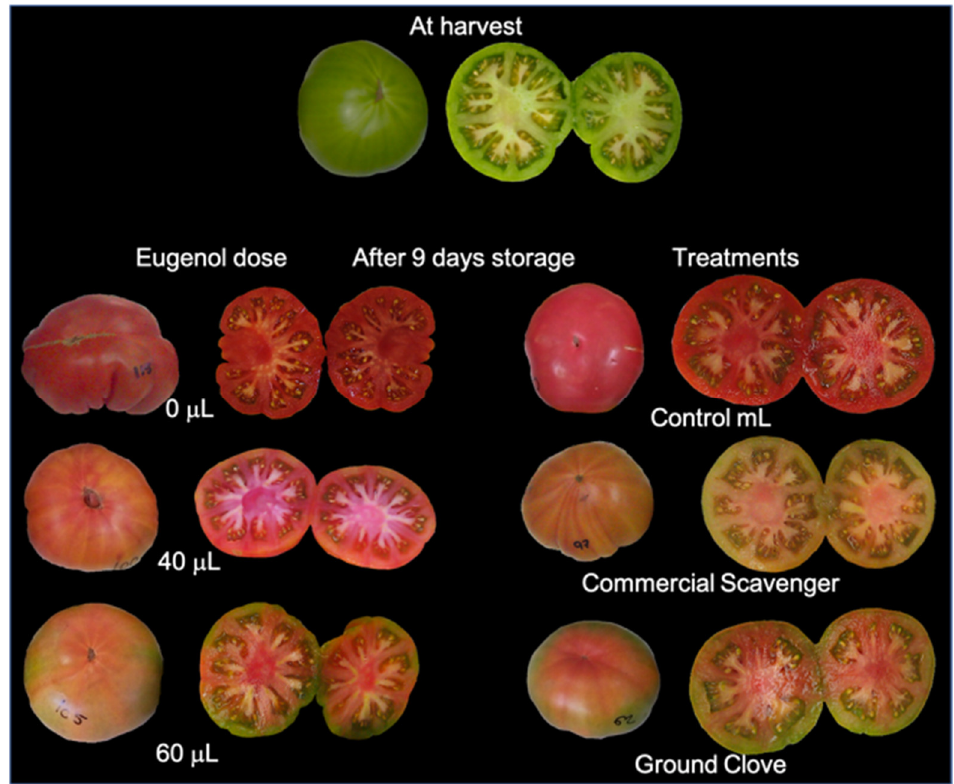
Figure 4. Tomato fruit at harvest and after 9 days of storage for preliminary experiment ( left ) and main experiment ( Right ).